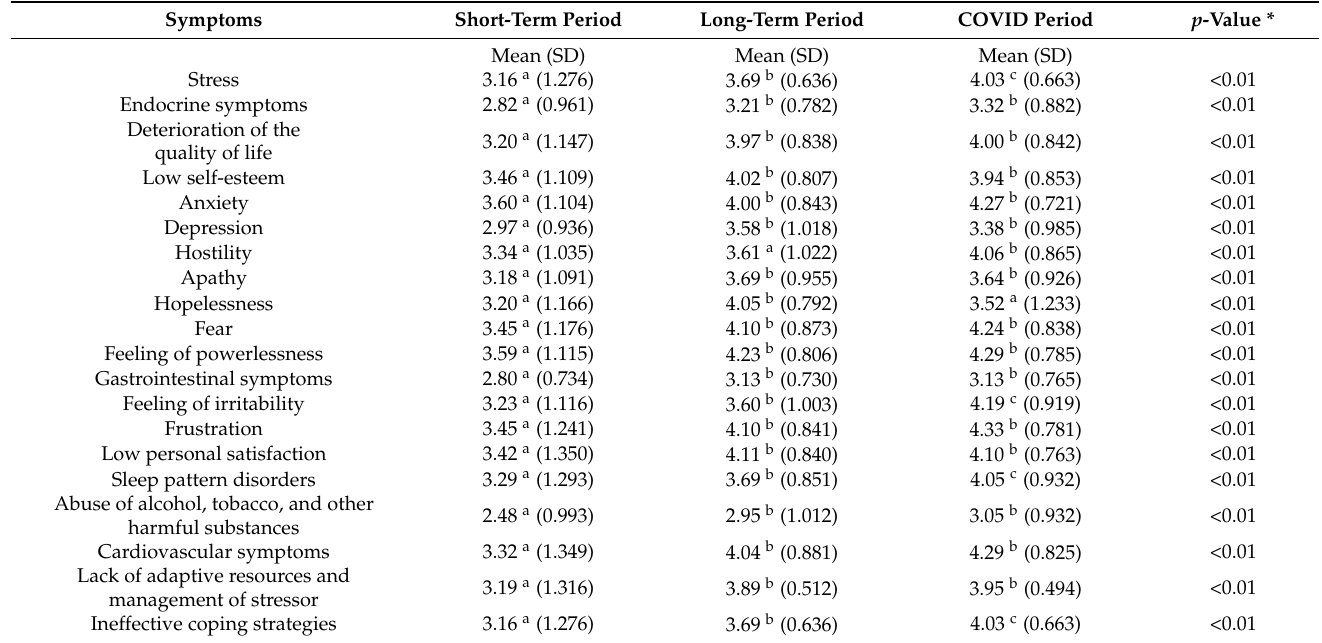
Table 2. Means differences for USS